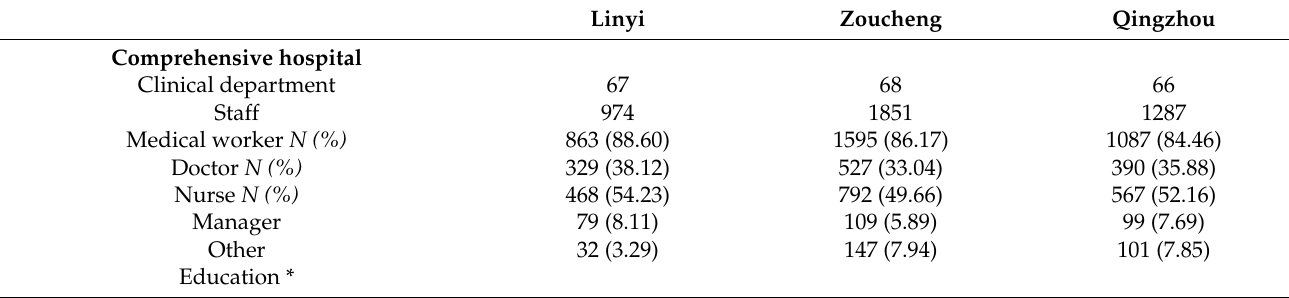
Table 1. Characteristics of the included 6